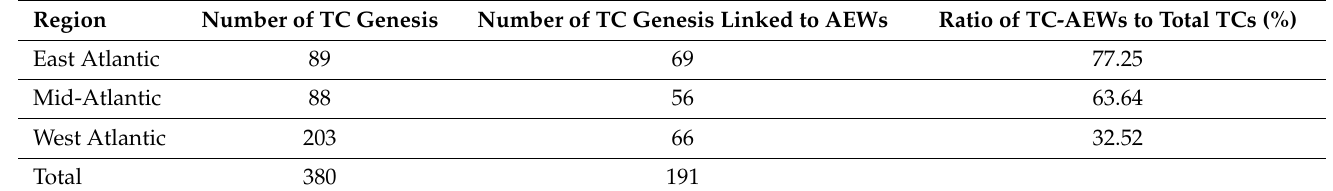
Table 1. Total numbers of tropical cyclogenesis, numbers of TC genesis linked to AEWs, and the ratio of TC genesis linked to AEWs to that total TC genesis during July to October 1984 to